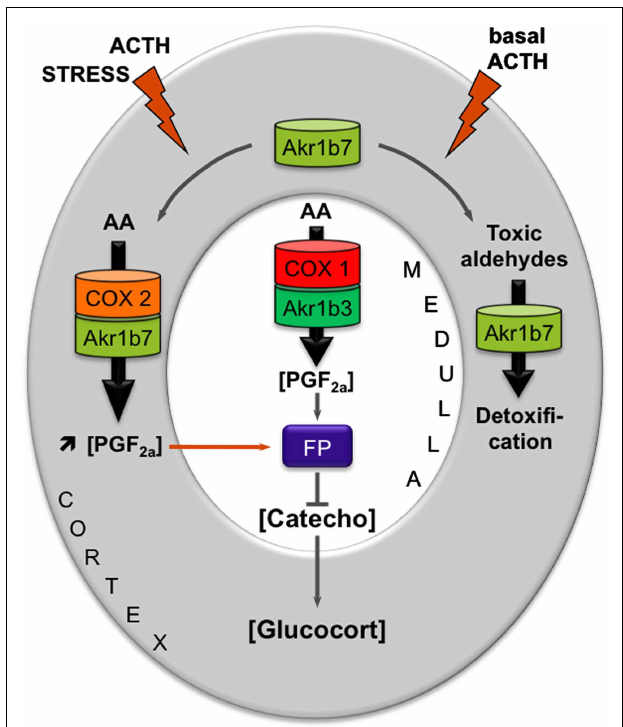
FIGURE 2 | Proposed model integrating dual functions of aldose reductases in the regulation of adrenal endocrine functions. Free arachidonic acid (AA) is metabolized into PGH 2 by COX enzymes and then converted into PGF 2 α by PGFS of the AKR1B family. FP receptor expression is restricted to the medullary zone. PGF 2 α synthesized in both the cortex and medulla thus signals in an autocrine/paracrine manner on chromaffin cells.This inhibits catecholamines production. Catecholamines produced in the medulla normally stimulate glucocorticoids release by the cortex. Decreased catecholamines production in response to PGF 2 α stimulation thus results in a decrease in glucocorticoids production.The differential expression and regulation of both COX and AKR1B enzymes within the adrenal zones could allow the adjustment of PGF 2 α production to limit stress response or control basal steroidogenesis by finely tuning glucocorticoids secretion. In basal conditions, chromaffin cells of the medullary zone constitutively secrete PGF 2 α , through the functional coupling between COX-1 and possibly the PGFS Akr1b3. Under stress conditions, the resulting ACTH surge induces COX-2 expression and sustains Akr1b7 levels in the cortex.The functional coupling between COX-2 and Akr1b7 triggers a PGF 2 α surge that could act as a local paracrine feedback to limit catecholamine-mediated glucocorticoid release. After the stress response has ended, COX-2 returns to undetectable levels.The coupling between Akr1b7 and COX-2 does not take place. Akr1b7 then functions only as a detoxifying enzyme of the harmful aldehydes produced under chronic/basal stimulation of steroidogenesis. Catecho, catecholamines; Gluco,